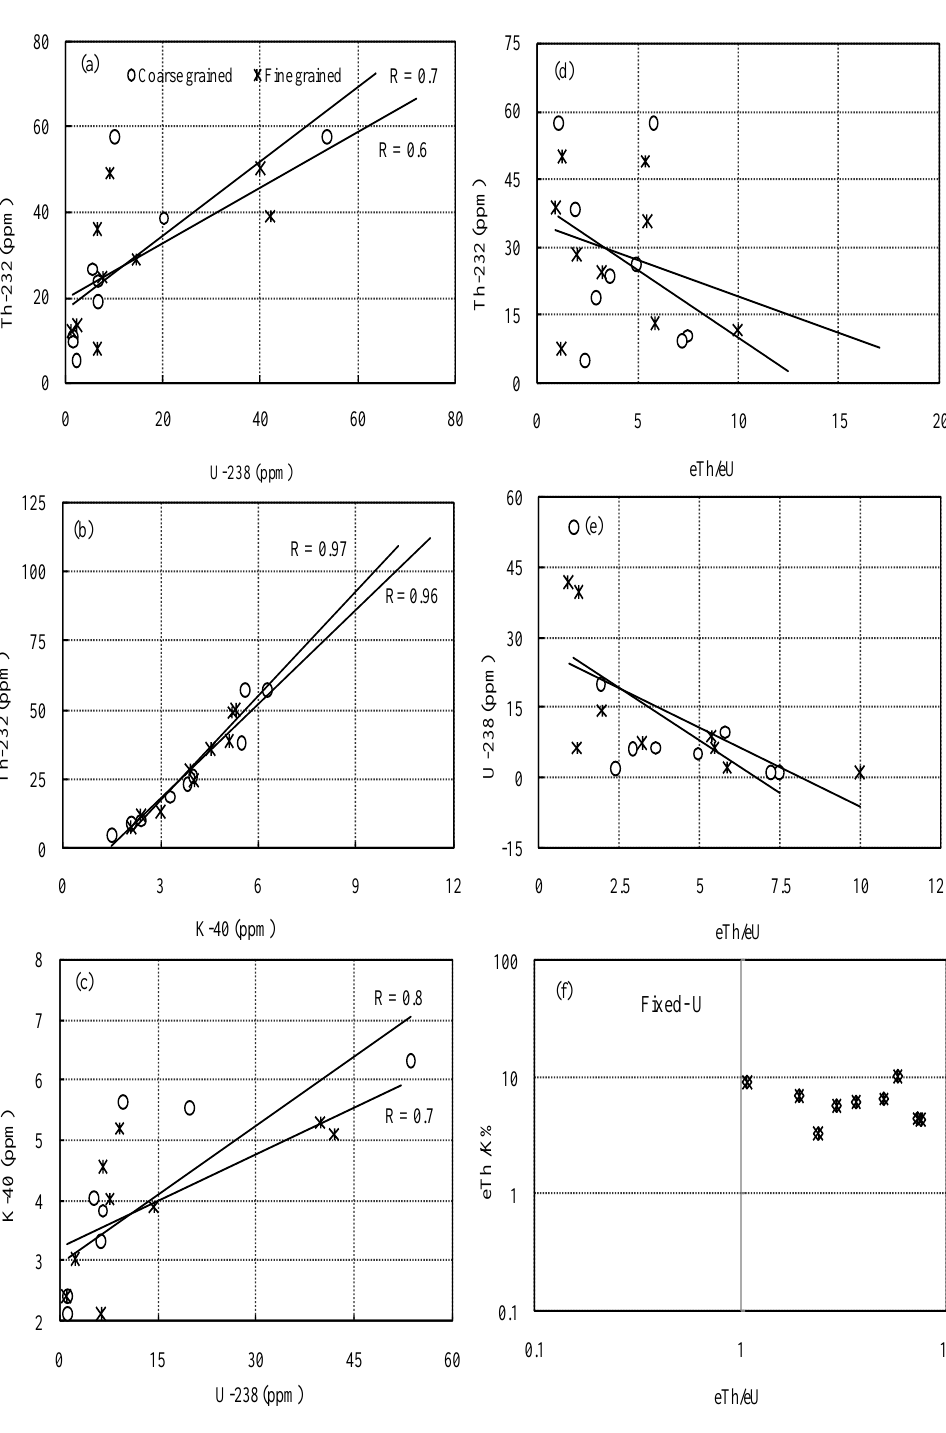
Figure 7. ( a ) Th vs. U, ( b ) Th vs. K, ( c ) K vs. U, ( d ) eTh vs. eTh/eU, ( e ) eU vs. eTh/eU, and ( f ) eTh/K% vs. eTh/eU for coarse-grained and fine-grained granites of the Sol Hamed area.